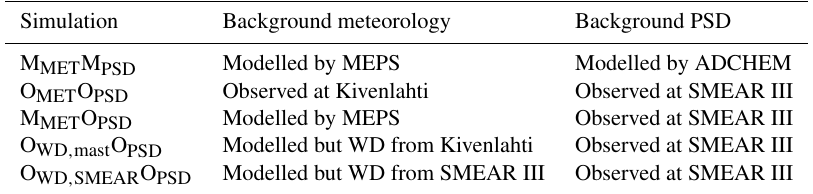
Table 4. Simulation abbreviations. WD is the wind direction and PSD is the aerosol particle number size distribution. Simulation Background meteorology Modelled by